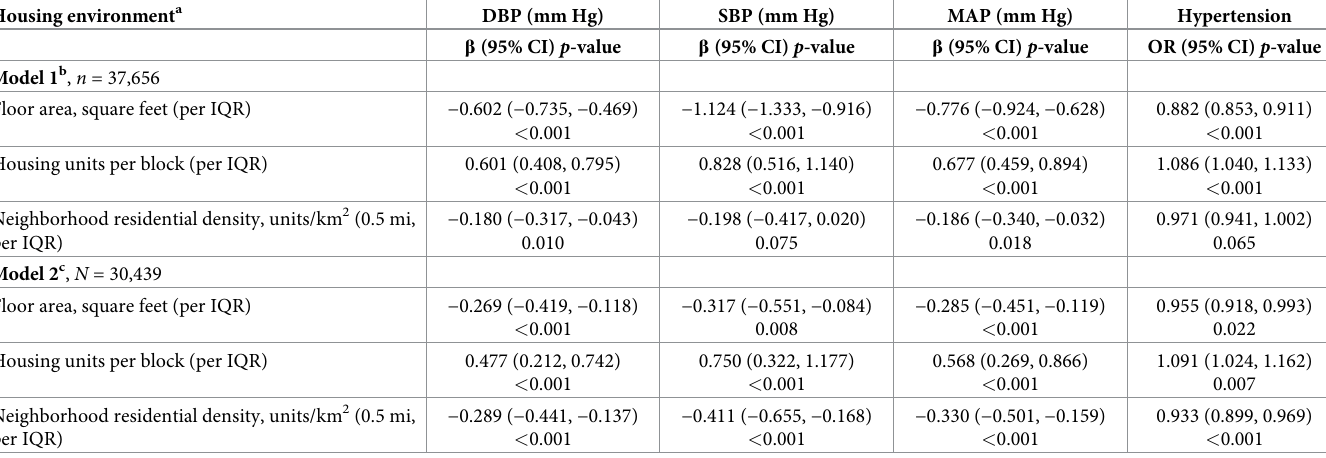
Table 2. Cross-sectional association of housing environment exposures with measures of blood pressure outcomes and prevalent hypertension among FAMILY Cohort participants aged 16 or above at baseline. Housing environment